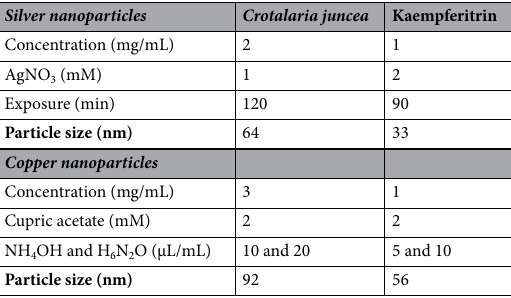
Table 1. Optimized variables for synthesis of Silver/Copper nanoparticles and their particle size.